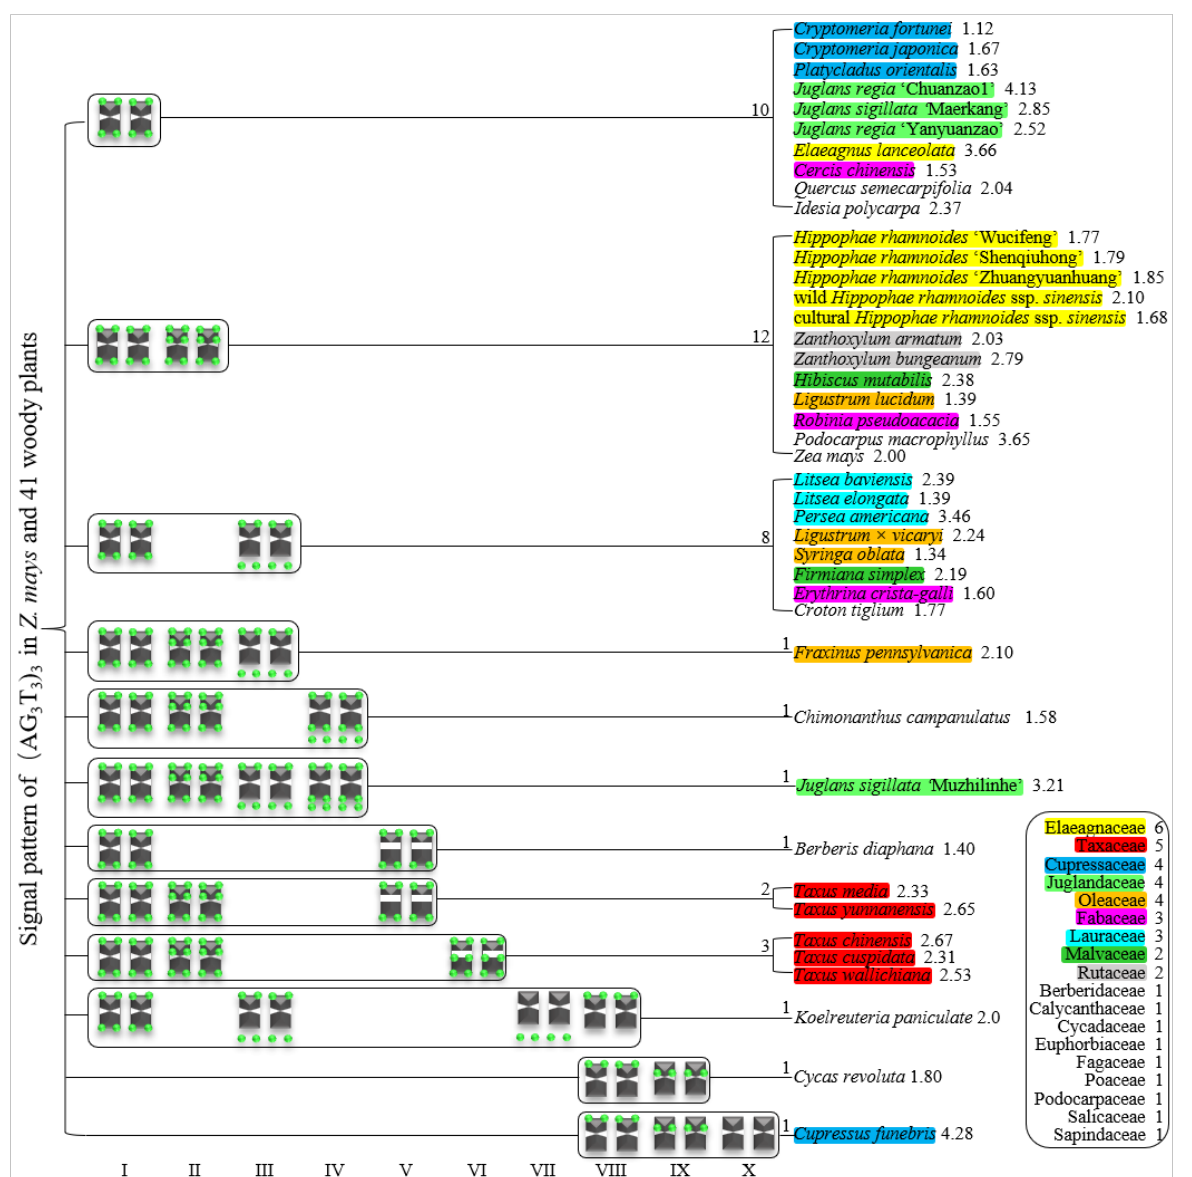
Figure 10. Signal pattern of (AG 3 T 3 ) 3 in Z. mays and 41 woody plants. Signal patterns type I – X are